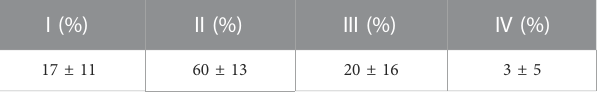
TABLE 1 Mean ± S.D. characteristic loading times resulting from the cyclic displacement applied during the dynamic cultures; where I : T load < 0 . 1 s , II: